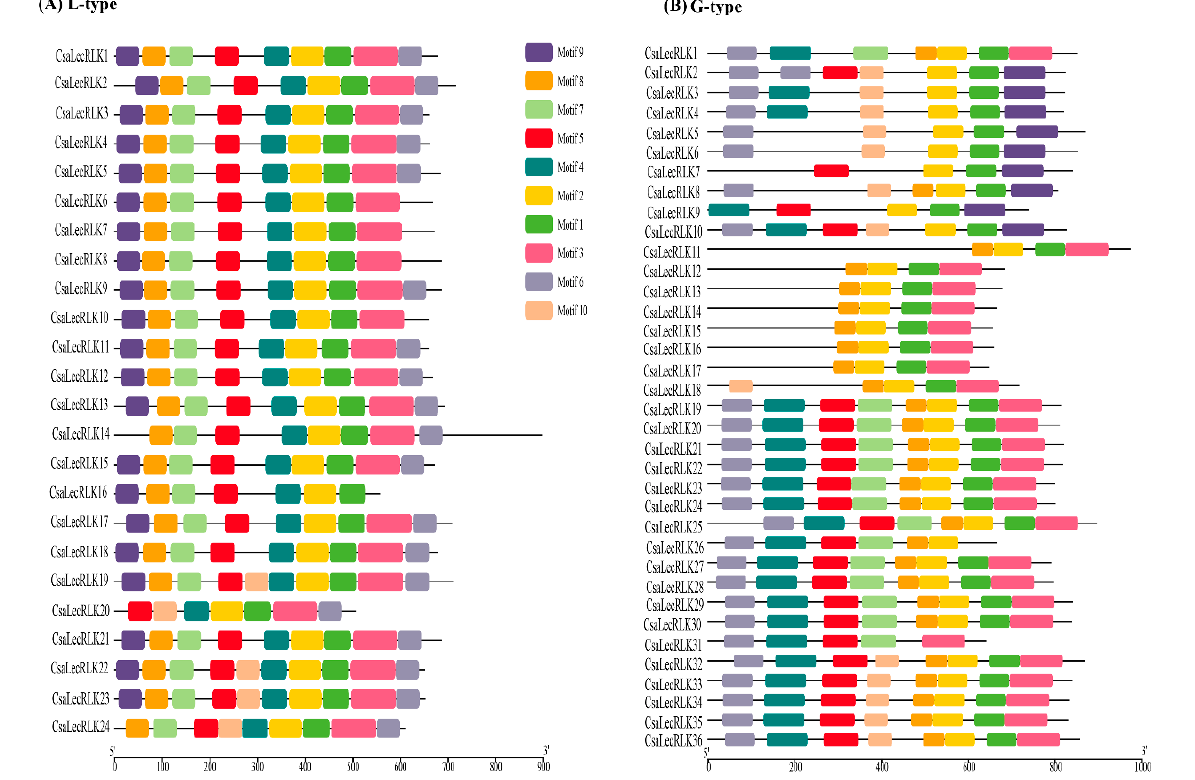
Figure 2. Conserved motif structure and up-/downstream regions of ( A ) L-type LecRLK and ( B ) G-type LecRLK proteins. The relative position is proportionally displayed based on the kolibase (KB) scale at the bottom of the figure.